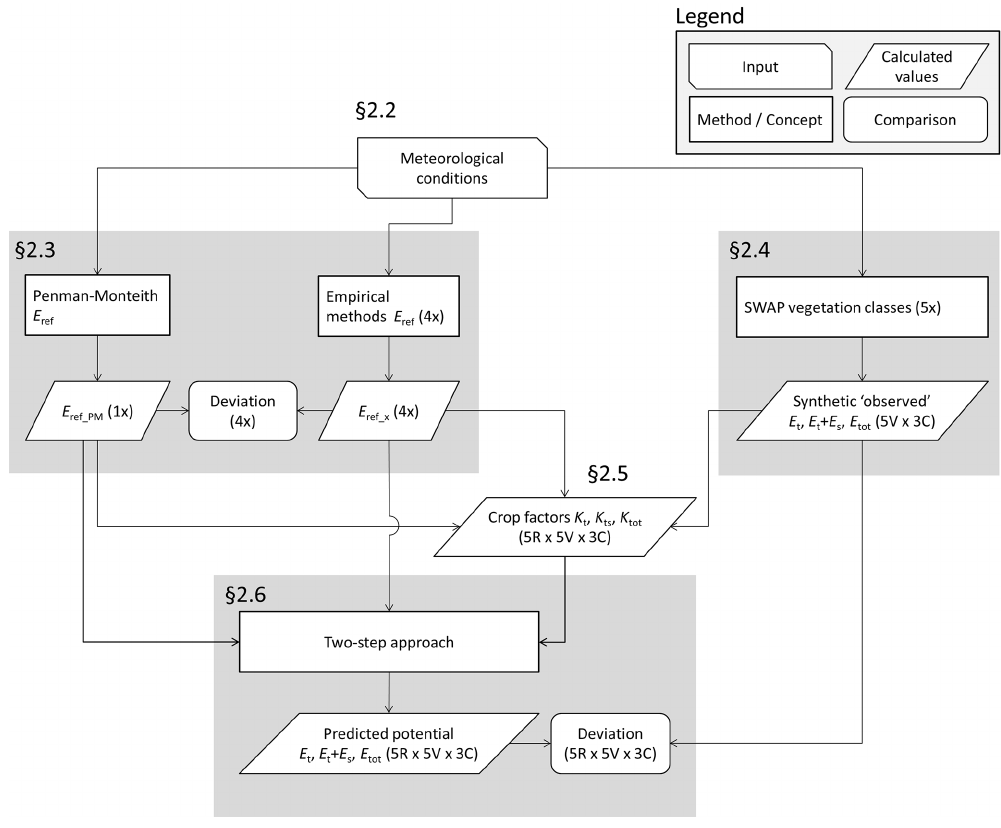
Figure 2. Flow chart of the methodology followed. E ref_x = E ref of empirical methods Mak, Har, PT and BC; R = number of reference evaporation methods, V = number of vegetation classes, and C = number of evaporation components. For the explanation of the other abbre- viations, we refer to the